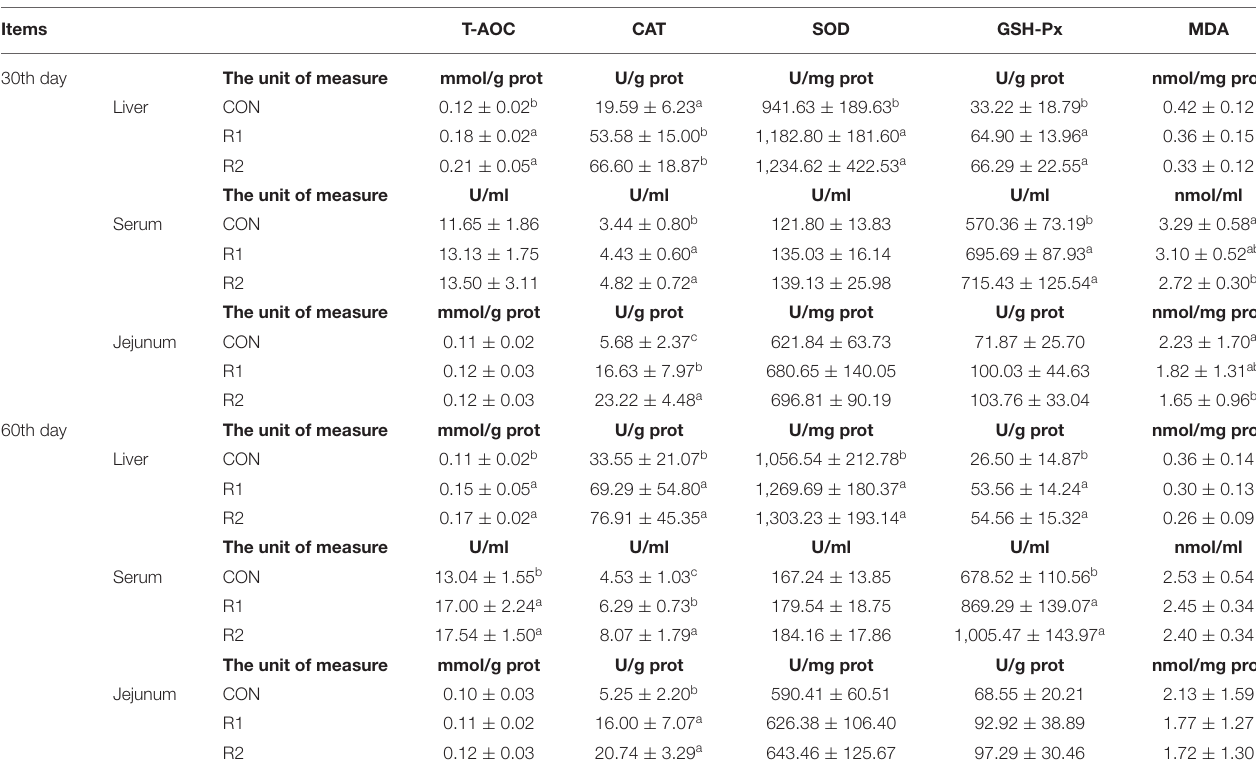
TABLE 5 | Effects of CAT on antioxidant indices of yellow broilers. Items